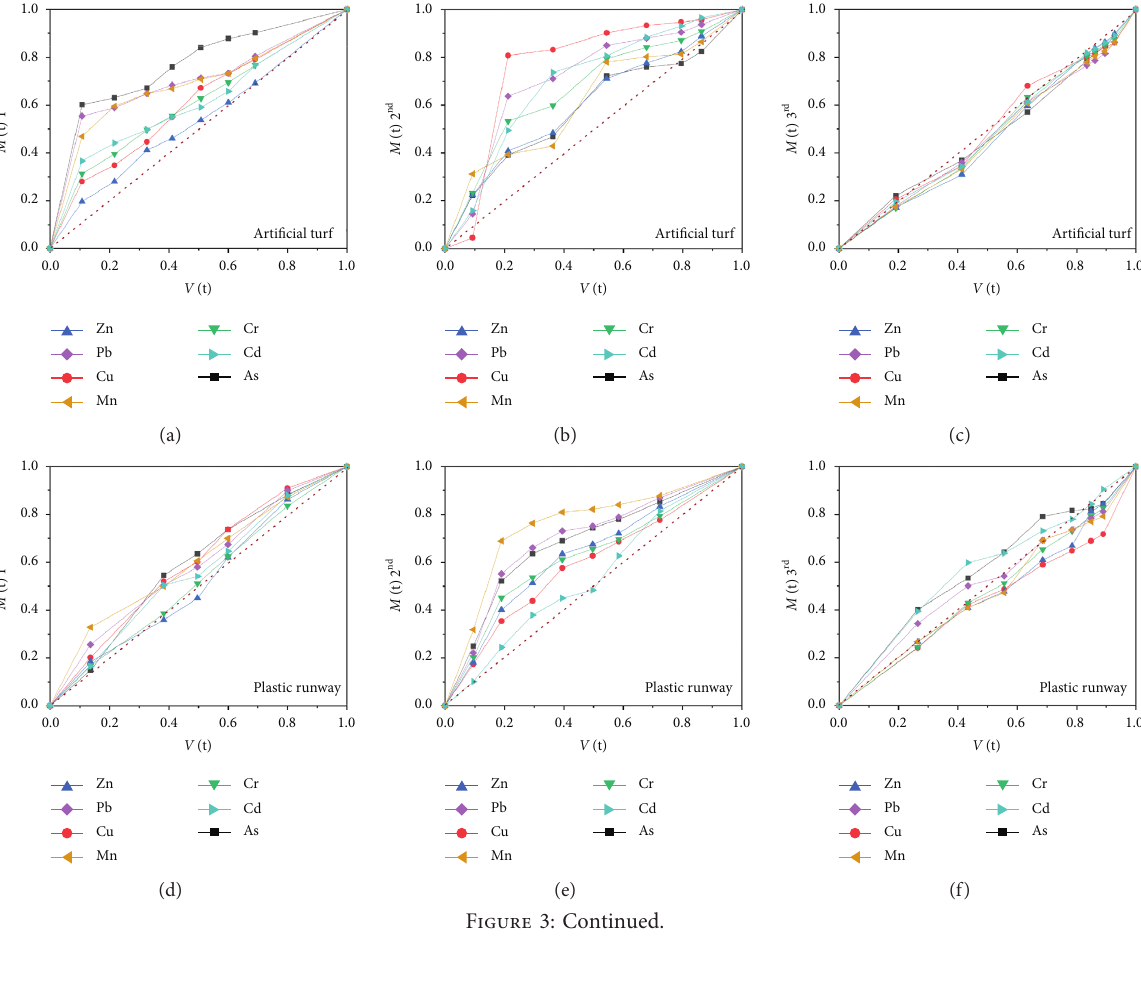
Figure 2: Concentration of heavy metals and metalloid under different rainfall events and durations in five athletic fields.